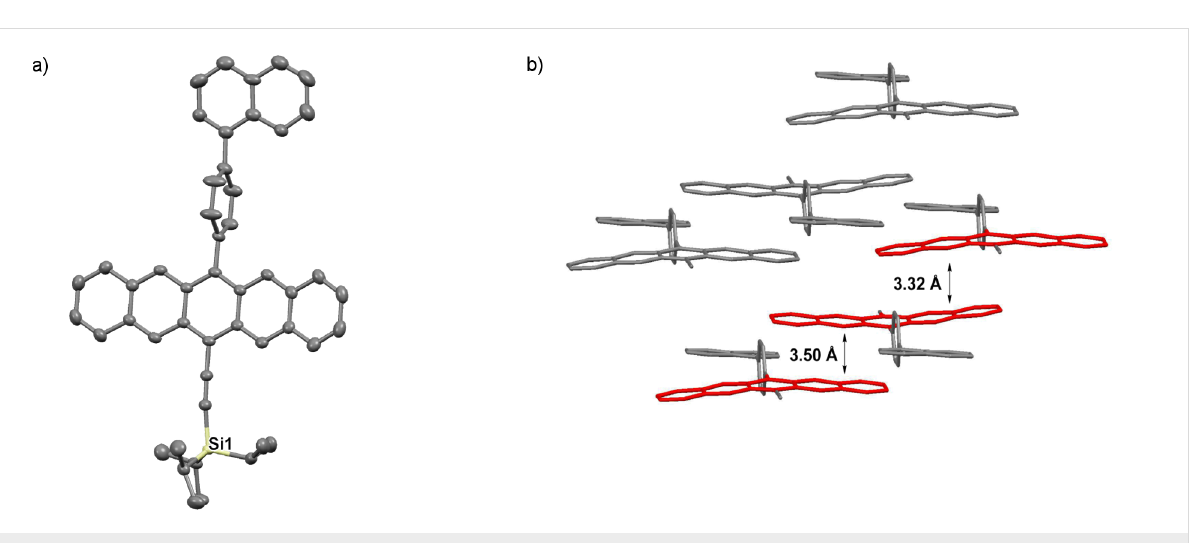
Figure 12: X-ray crystallographic analysis of 3j showing a) molecular structure and b) packing motif (triisopropylsilyl groups omitted for clarity); ORTEP drawn at 50% probability level.